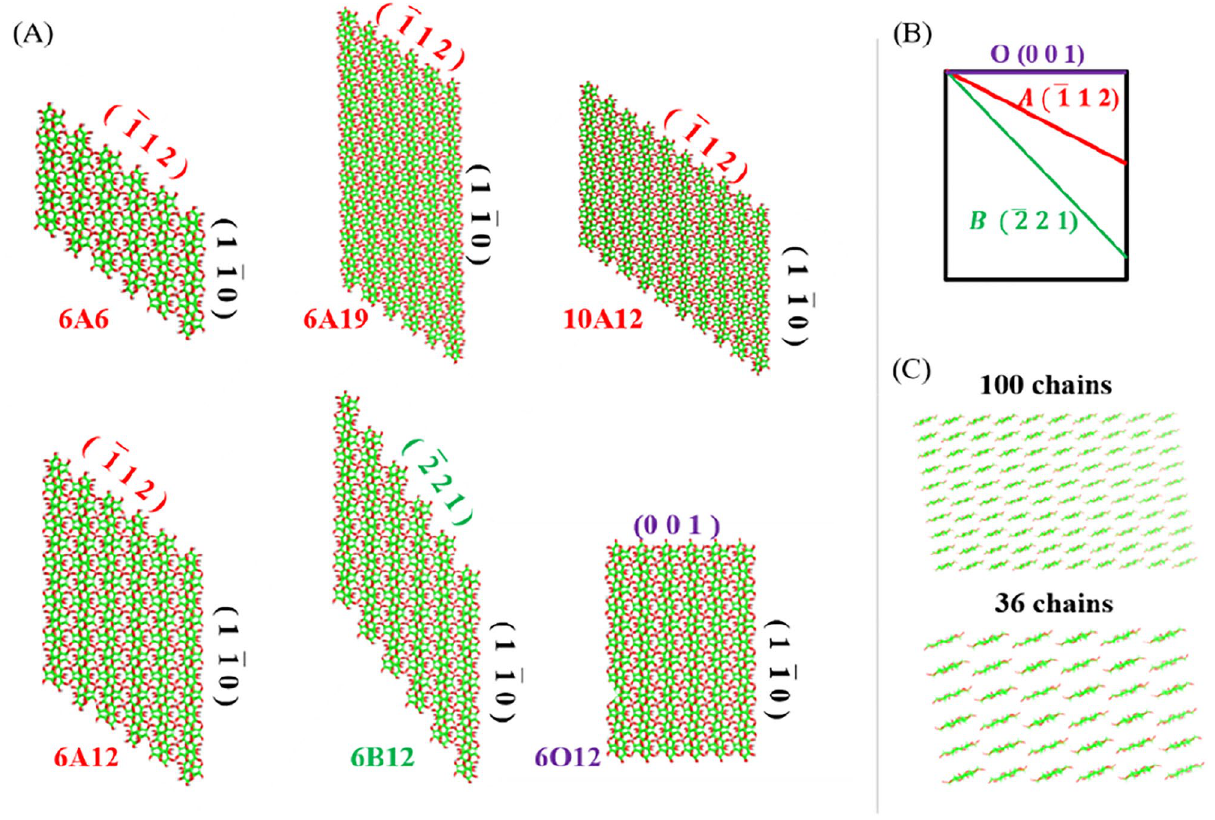
Figure 2. The structure and crystal facets of cellulose II nanocrystals. ( A ) The geometry of six types of cellulose II nanocrystal models. 6A6, 6A12, 6A19, and 10A12 denote 6 × 6 × 6, 6 × 6 × 12, 6 × 6 × 19, and 10 × 10 × 12 the crystal models with the crystal facets ( 1 1 2 ) , respectively. 6B12 and 6O12 are 6 × 6 × 12 crystal models with ( 2 2 1 ) and (0 0 1) as crystal facets respectively; ( B ) Three types of inclined crystal facets. (C) 6 × 6 and 10 × 10 are the chain numbers of the ab base plane